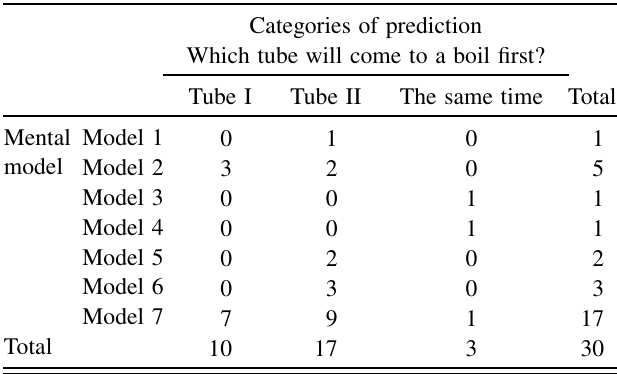
convection in the different tubes. The participants who TABLE II. Cross comparison of the participants’ mental mod-